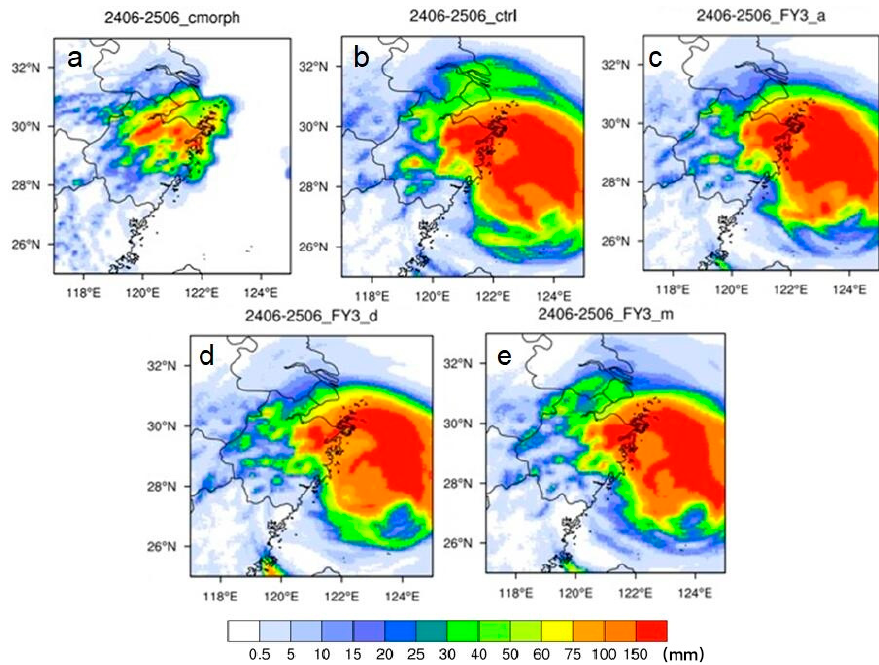
Figure 11. Accumulated precipitation from 0600 UTC 24 July to 0600 UTC 25 July 2021 ( a ) observa- tions, ( b ) CTRL, ( c ) fy3_a, ( d ) FY3_d, ( e ) FY3_m (unit: mm).